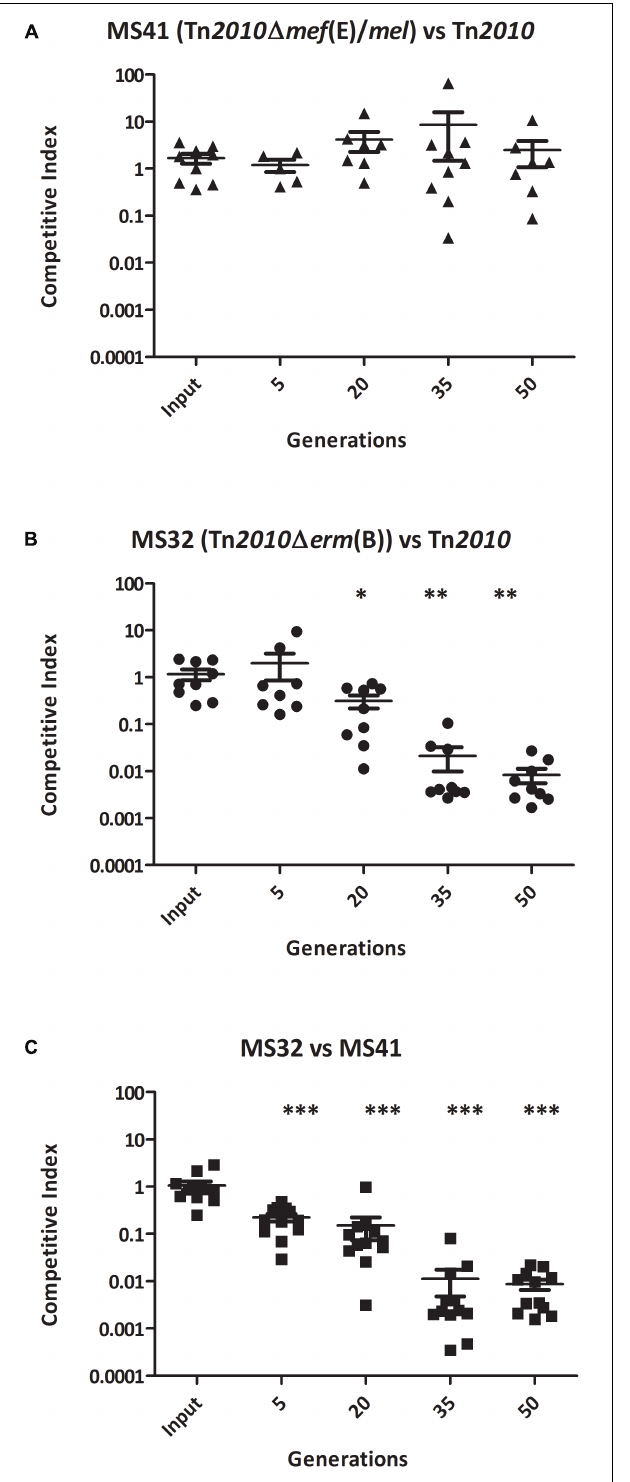
FIGURE 2 | The competitive index of isogenic GA44288 Tn 2010 mutants grown in vitro with erythromycin (0.5 µ g/ml) for approximately 50 generations: (A) MS41 [Tn 2010 (cid:49) mef (E)/ mel ] versus Tn 2010 , (B) MS32 [Tn 2010 (cid:49) erm (B)] versus Tn 2010 , and (C) MS32 [Tn 2010 (cid:49) erm (B)] versus MS41 [Tn 2010 (cid:49) mef (E)/ mel ]. ∗ p < 0.05, ∗∗ p < 0.01, ∗∗∗ p < 0.001.